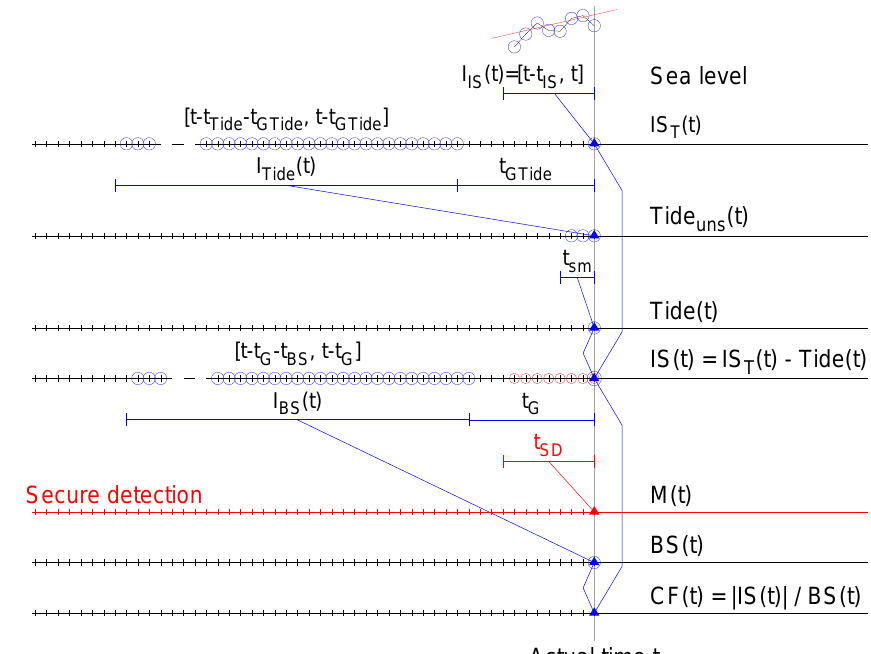
Fig. 1. Scheme of TEDA functions and of the TEDA time intervals described in the text. BS2 (t) = standard deviation of IS (t 0 )